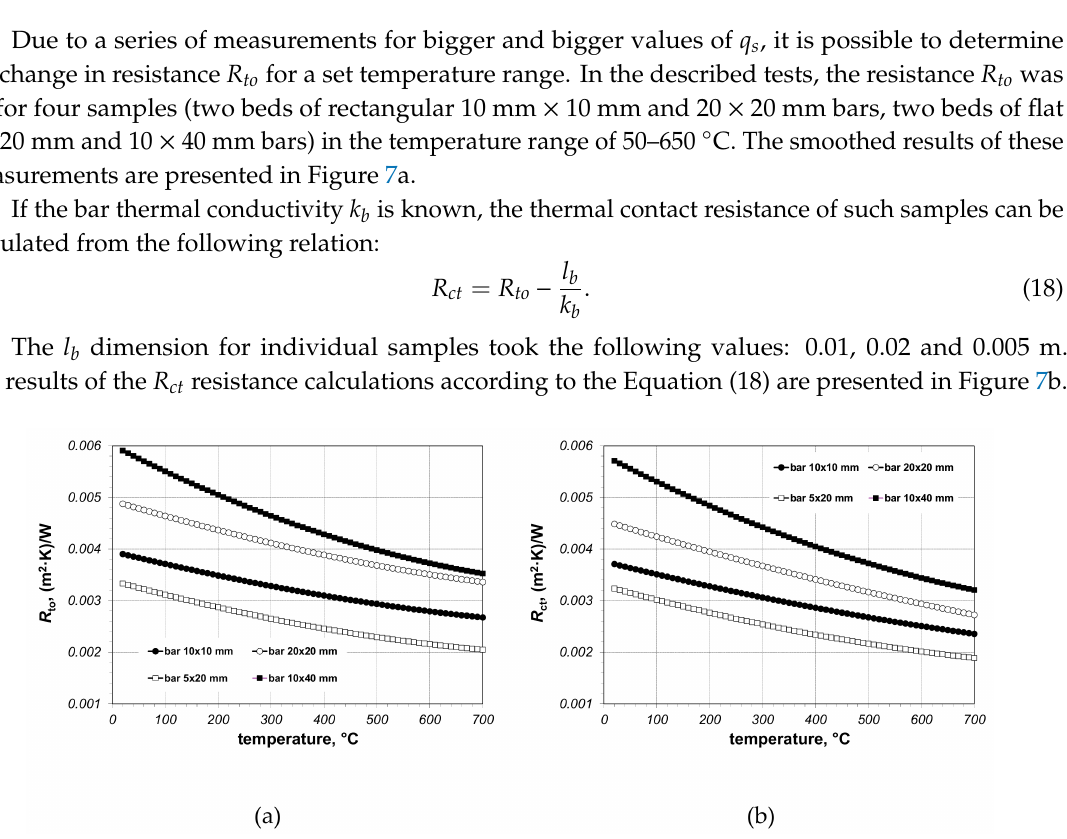
Figure 6. Examples of the investigated samples: ( a ) a bed of square bars and ( b ) a bed of flat bars.